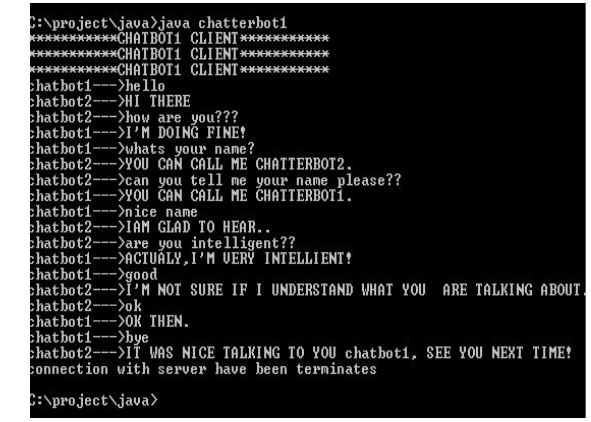
FIG. 6. AN INTERFACE OF CLIENT CHATBOT